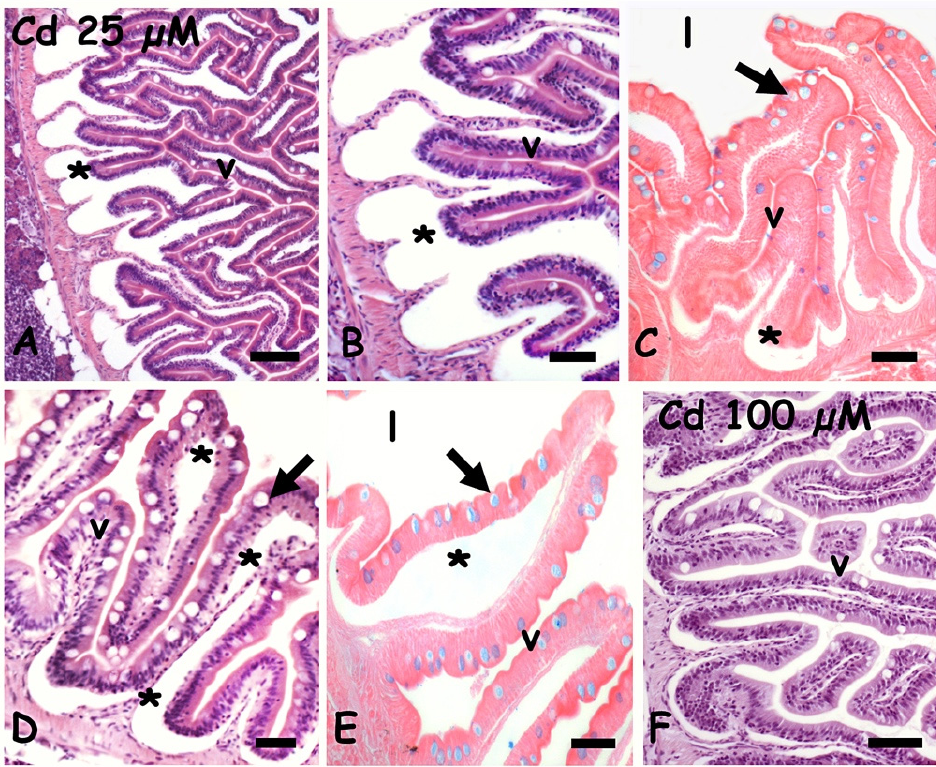
Figure 2. Danio rerio anterior ( A , C , F ) and mid ( D , E ) intestine exposed to waterborne cadmium. ( A ) Seric infiltrates (*) between connectives and mucosal epithelium. Villi (v). ( B ) Detail. ( C ) Poorly stained goblet cells (arrow) in villi (v) with seric infiltrates (*); gut lumen (l). ( D ) Seric infiltrates in lamina propria (*) and goblet cells (arrow). ( E ) Poorly stained goblet cells (arrow) in villi (v) showing extensive seric infiltration (*); gut lumen (l). ( F ) Intact villi (v). Hemalum-eosin staining ( A , B , D , F ); Alcian-blue-eosin counterstaining ( C , E ). Bars: 150 µm ( A ), 100 µm ( B , C , F ), 50 µm ( D , E ).